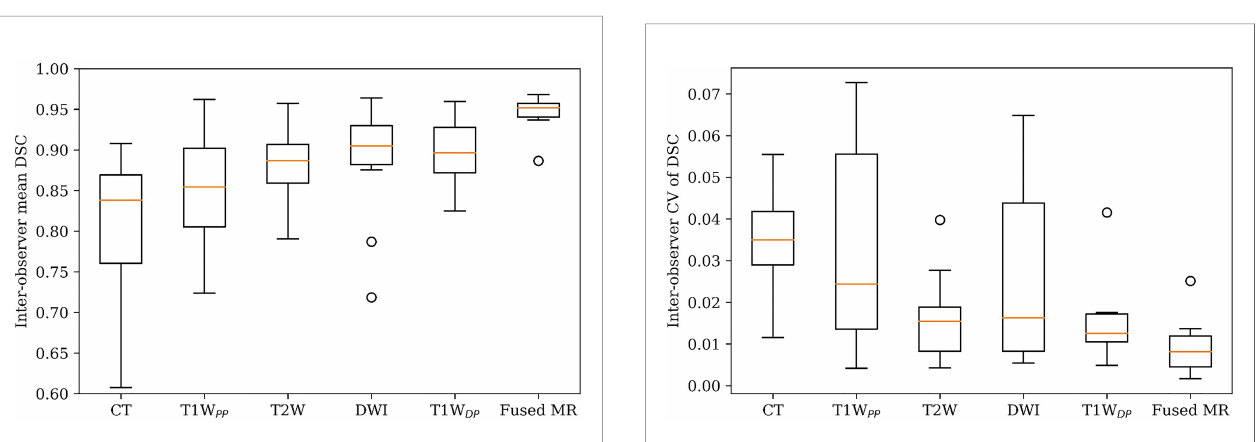
FIGURE 3 | GTV delineation inter-observer mean DSC on planning CT, four original MR image sets, and fused MRI. GTV, gross tumor volume; DSC, Dice similarity coef fi